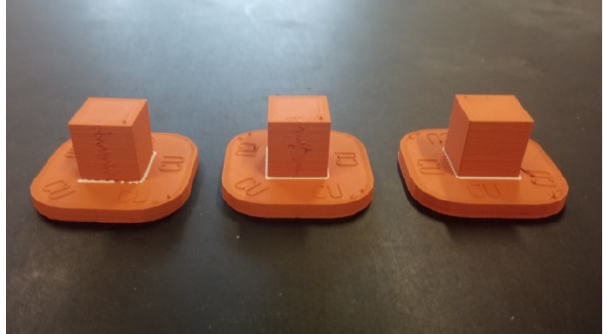
Figure 4. Cubic test samples manufactured by ADAM technology.